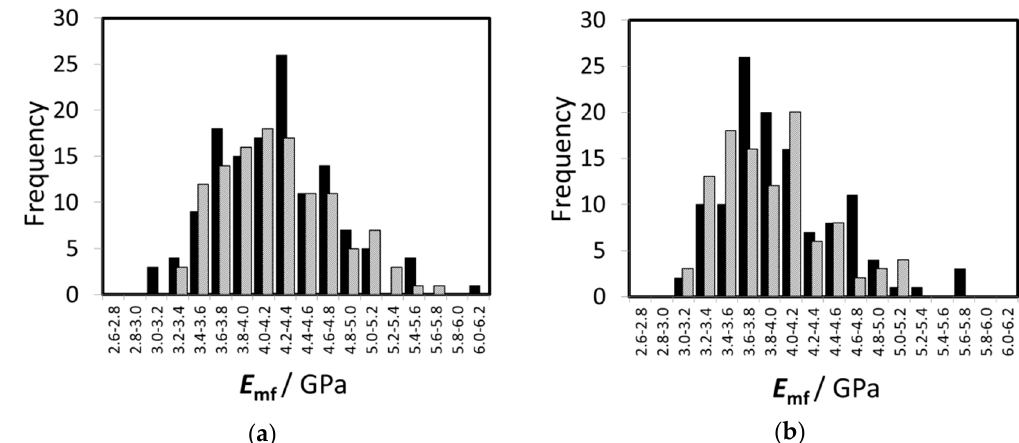
Figure 5. Histograms of elastic modulus inside macrofibrils ( E mf ) evaluated by AFM nanoindentations at about 27 ◦ C and 65% RH. ( a ) an African-American hair; ( b ) a Japanese hair. Black bars, para-like cortical cells; shaded bars, ortho-like cortical cells. The total indentation numbers were 134 and 119 for para-like and ortho-like cortical cells in ( a ), respectively, and 119 and 105 for para-like and ortho-like cortical cells in ( b ), respectively. The averaged E mf values of para-like and ortho-like cortical cells for the African-American hair were the same (4.0 GPa) and those for the Japanese hair were 3.8 GPa and 3.7 GPa, respectively.